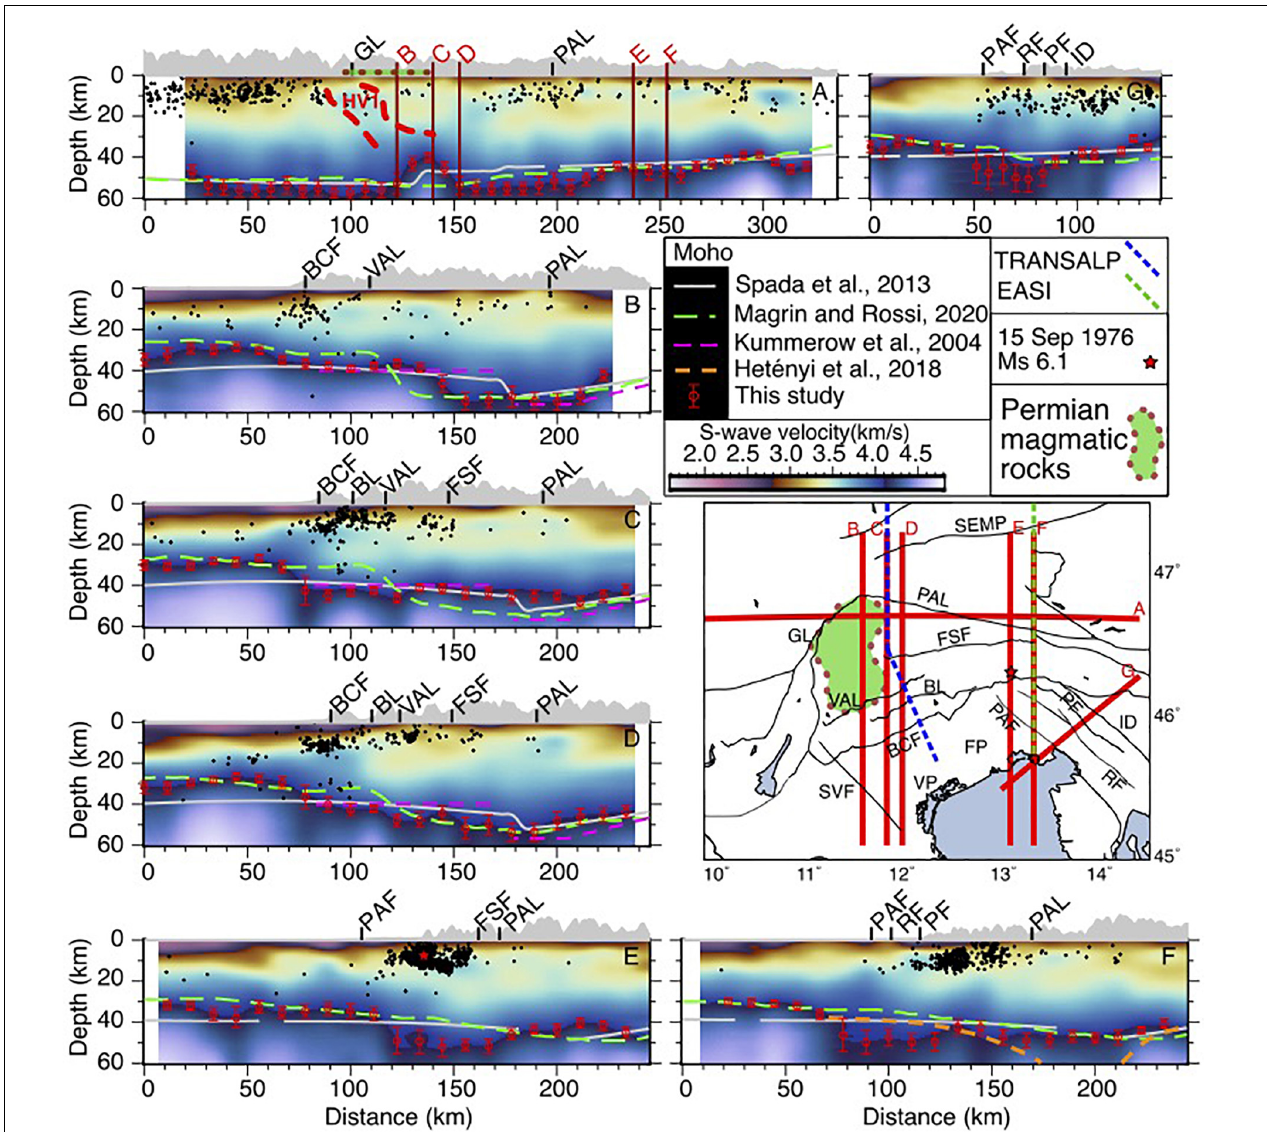
FIGURE 10 | Cross sections of the S-wave velocity model. The seismic events within 0.05 ◦ from the profiles are extracted from the OGS catalog (Friuli-Venezia Giulia Seismometric Network Bulletin, 2019) and projected along the sections. PAL, Periadriatic Line; GL, Giudicarie Line; FP, Friuli Plain; VP, Venetian Plain; SEMP, Salzach-Ennstal-Mariazell-Puchberg; VAL, Valsugana thrust; BL, Belluno Line; FSF, Fella-Sava Fault; ID, Idrija Fault; BCF, Bassano-Cansiglio Fault; PAF, Palmanova fault; RA, Rasa fault; PF, Predjama